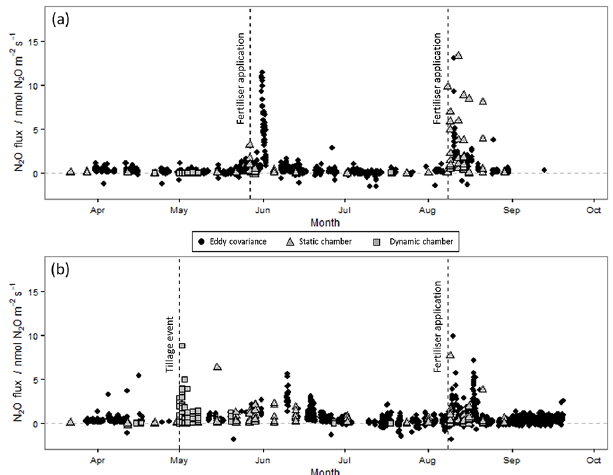
Figure 5. Fluxes of N 2 O from the (a) untilled and (b) tilled fields measured at the Easter Bush field site in 2012. Fertiliser was ap- plied to the untilled field on 28 May and to both fields on 9 Au- gust (vertical dashed lines). Tillage began on 1 May. The y axis is limited to 15nmolm − 2 s − 1 for better comparison between the fields. Only three static chamber measurements in the untilled field recorded fluxes above 15nmolm − 2 s − 1 in the first few days after the August